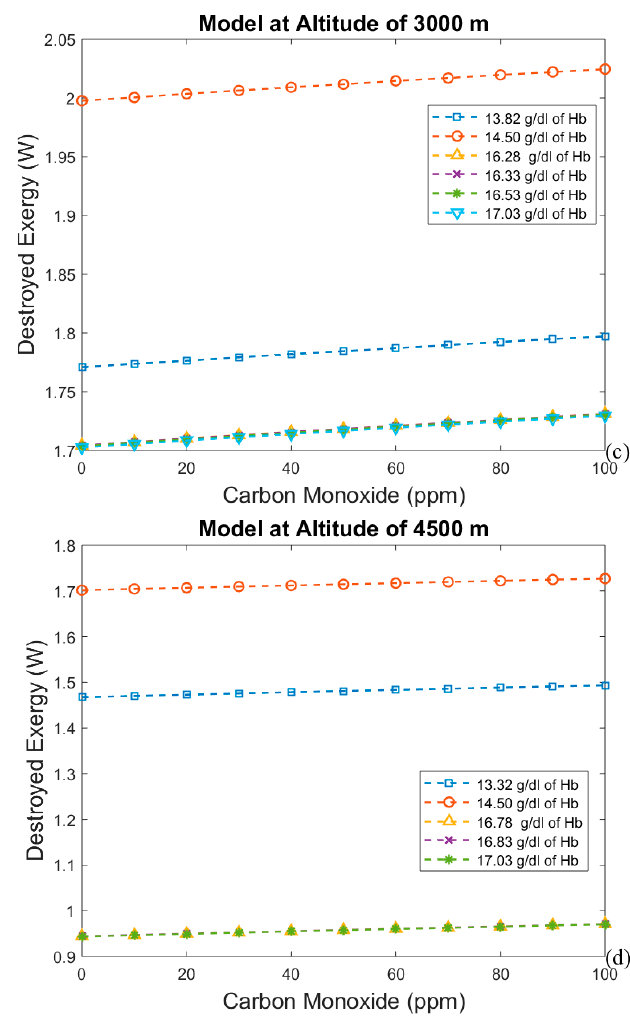
Figure 8. Destroyed exergy as a function of carbon monoxide and hemoglobin concentration at ( a ) 0 m, ( b ) 1500 m, ( c ) 3000 m, and ( d ) 4500 m.